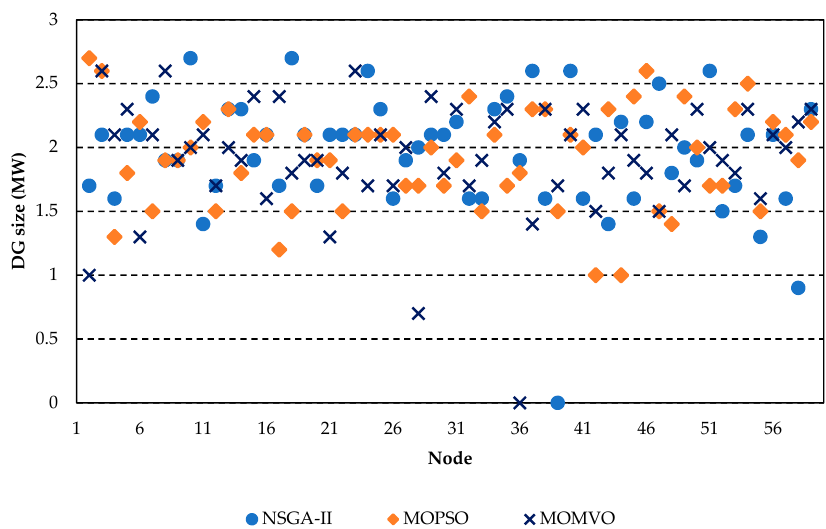
Figure 9. DG sizes at each node: 59-node distribution system.